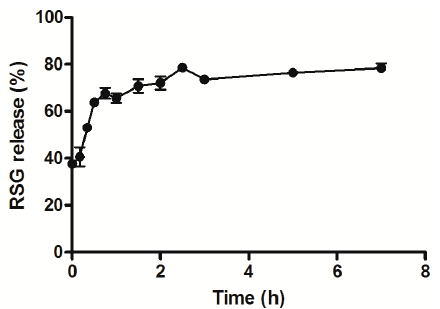
Figure 2. RSG release from nanoparticles in PBS at 37 °C, under sink conditions.